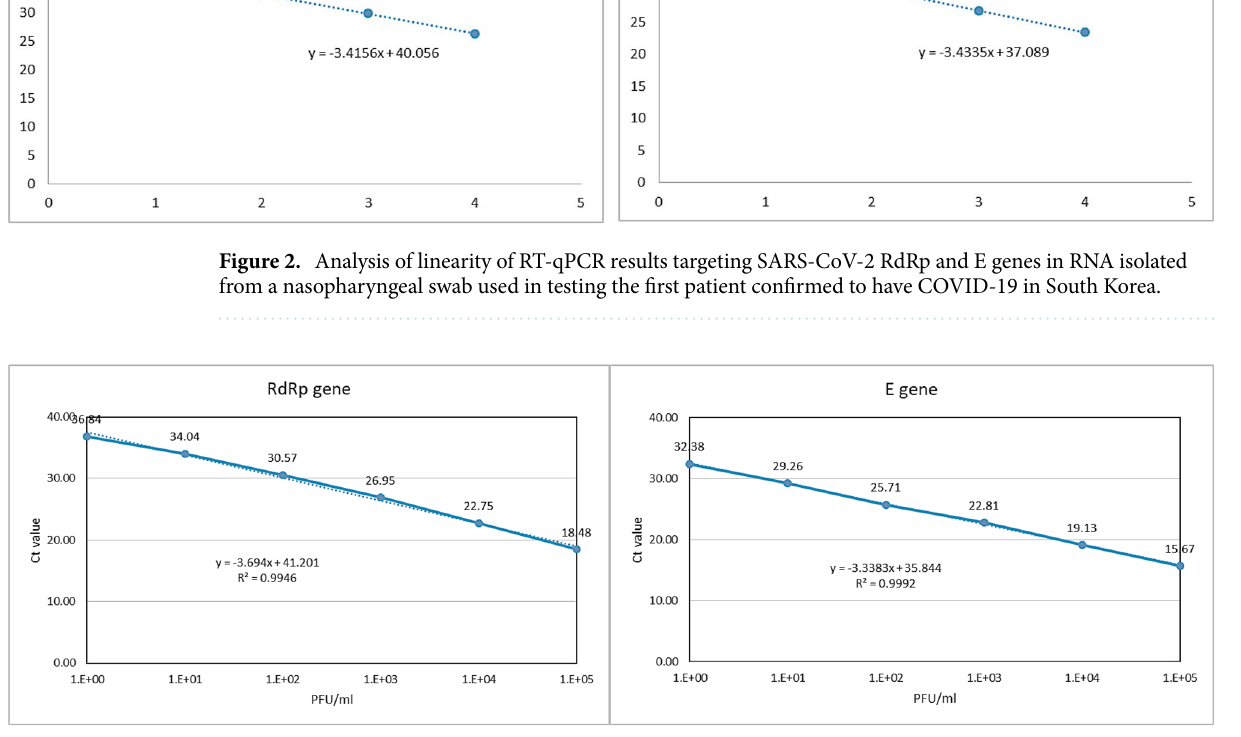
Figure 3. Analysis of linearity of RT-qPCR results targeting SARS-CoV-2 RdRp and E genes in RNA form virus